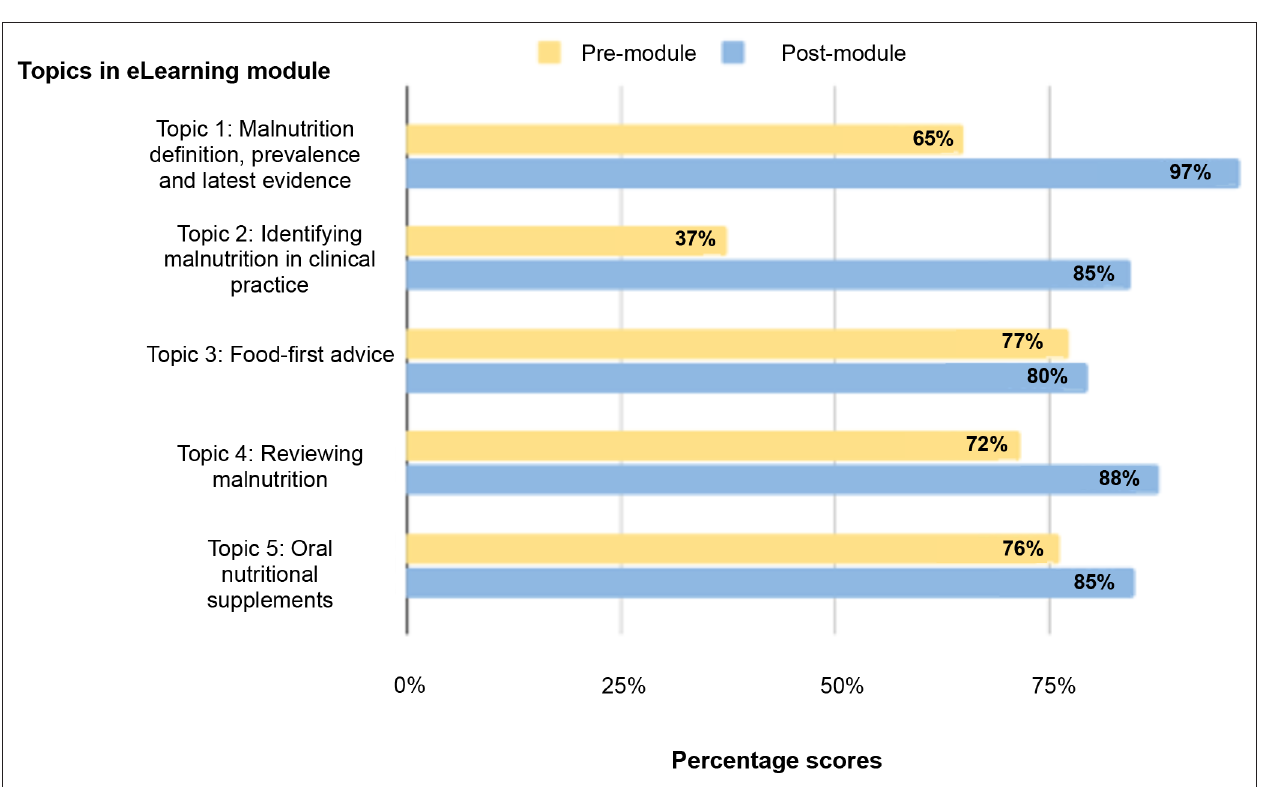
Figure 2 Mean GP multiple- choice questionnaire score ( n = 31) across module units at baseline (pre- module) and immediately post- completion of malnutrition e- learning